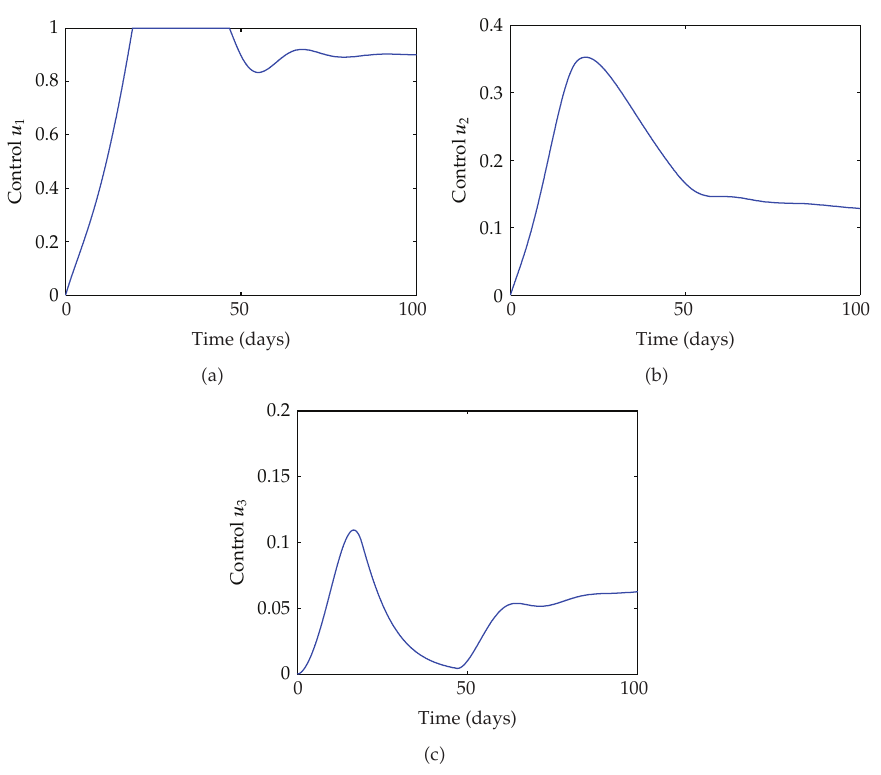
Figure 4: The plot represents the three controls (cid:6) 3.14 (cid:7) when A 1 (cid:9) 1, A 2 (cid:9) 1, A 3 (cid:9) 0 . 00001, B 1 (cid:9) 200, B 2 (cid:9) 50, (cid:9) B 3